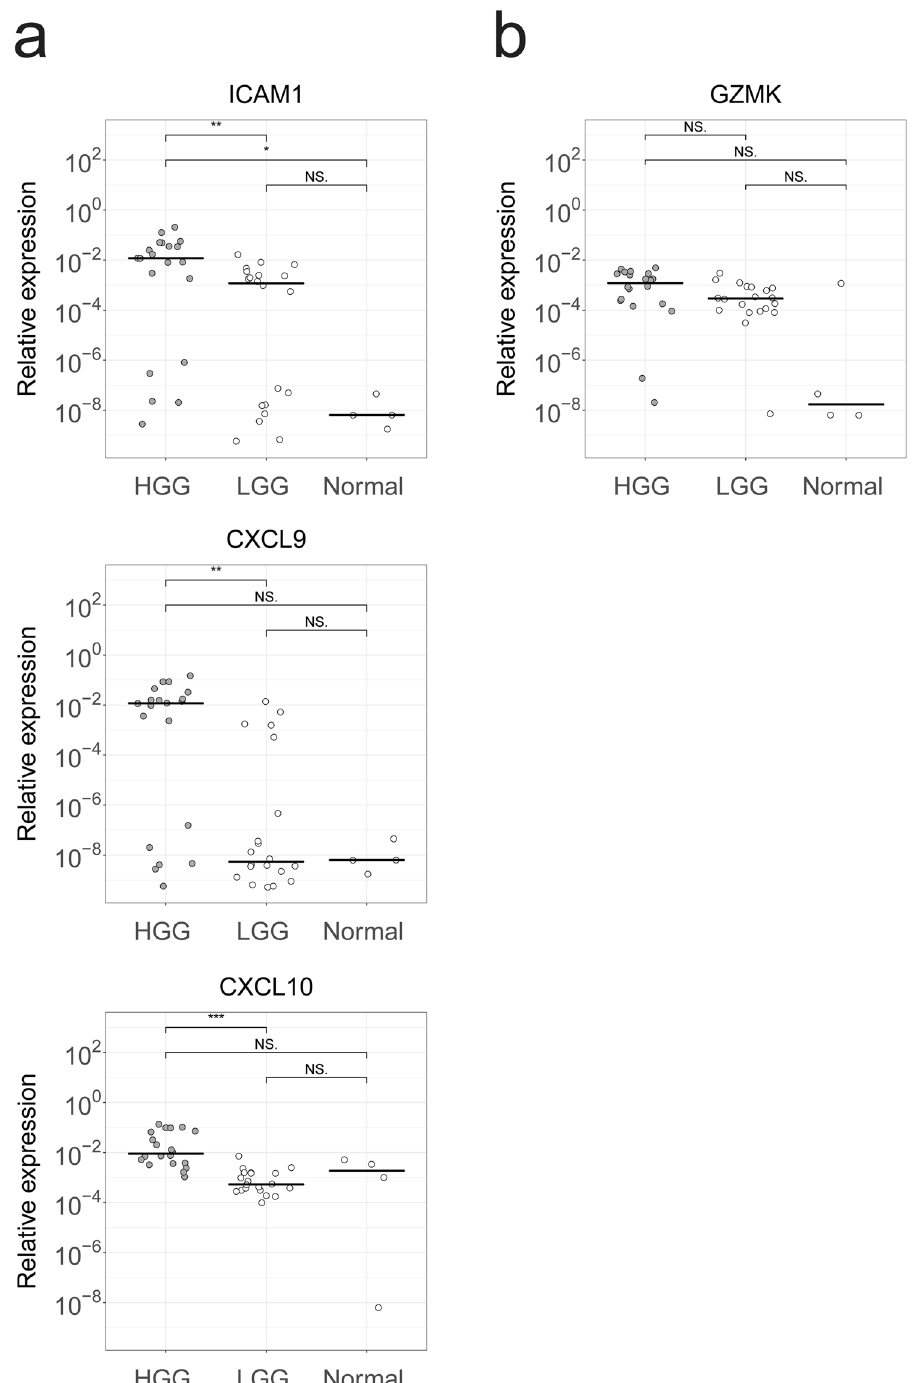
Figure 5. Decreased gene-expression of T cell trafficking molecules in LGG versus HGG. RT-qPCR was performed for HGG (n = 20) and LGG (n = 20) to determine gene expression levels of ( a ) the chemo-attractants CXCL9 and CXCL10, adhesion molecule ICAM1 and ( b ) the T cell effector molecule GZMK. Each dot represents an individual sample. Relative expression levels (2 −Δ Ct ) are shown according to log scale. Black bars show the median value. Expression levels of HGG and LGG are compared using the Mann-Whitney U test and p-values are FDR-corrected for multiple testing. *** P < 0.001, ** P < 0.01, * P < 0.05, NS = not